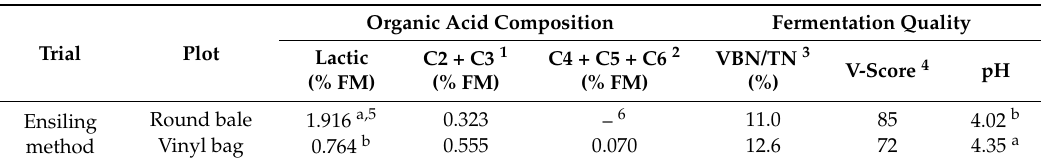
Table 4. Organic acids and fermentation quality in silages of dwarf Napiergrass ensiled in autumn season (Experiment